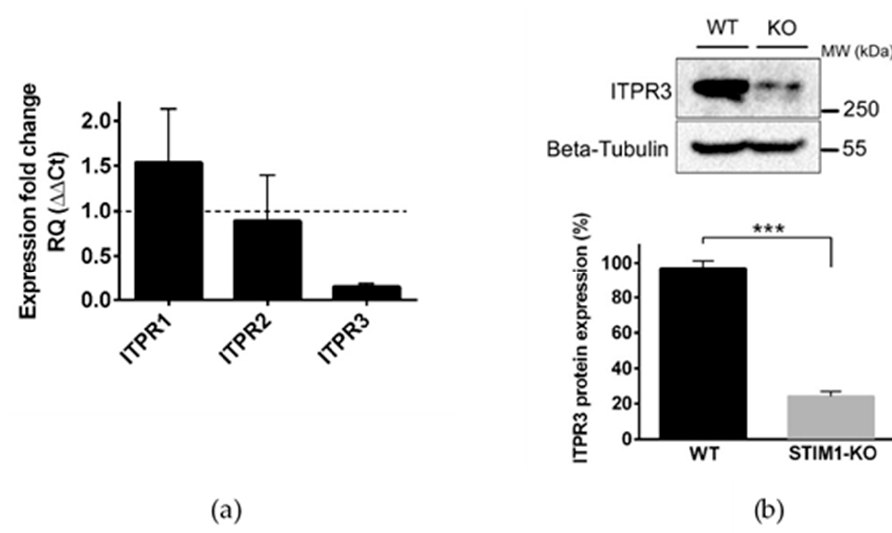
Figure A2. Downregulation of ITPR3 in differentiated STIM1-KO cells. ( a ) Quantification of ITPR1, ITPR2, and ITPR3 transcripts from differentiated STIM1-KO cells compared to wild-type cells. Data are mean ± S.D. from 2 different biological replicates with technical triplicates (n = 6). ( b ) ITPR3 protein expression in whole cell lysates was quantified in differentiated wild-type and STIM1-KO cells (beta- tubulin as a loading control). Data are mean ± S.D. from 2 independent experiments.